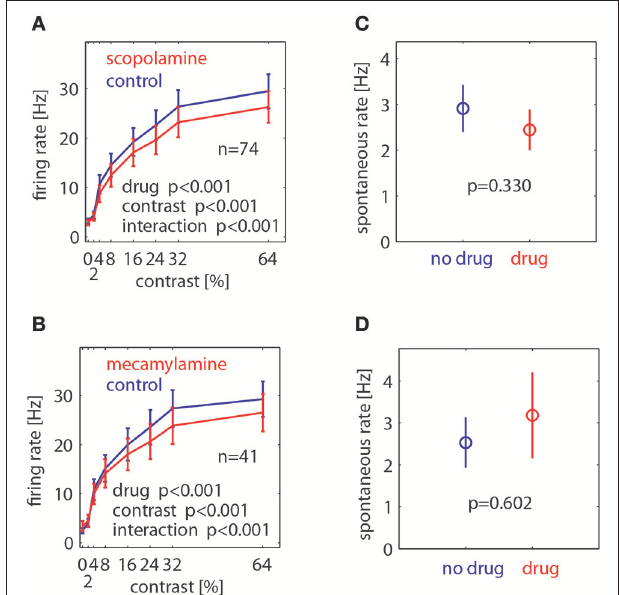
FIGURE 4 | Effect of muscarinic and nicotinic receptor blockade on neuronal firing rates at different stimulus contrasts and for spontaneous activity. (A) Effect of muscarinic receptor blockade (scopolamine application) on neuronal firing rates at different Gabor contrasts. (B) Effect of nicotinic receptor blockade (mecamylamine) on neuronal firing rates at different Gabor contrasts. (C) Effect of muscarinic receptor blockade on spontaneous activity. (D) Effect of nicotinic receptor blockade on spontaneous activity. Blue symbols show mean ± S.E.M of control activity, red symbols show mean ± S.E.M of drug applied activity. P -values indicate significance, number of cells recorded is indicated by the insets